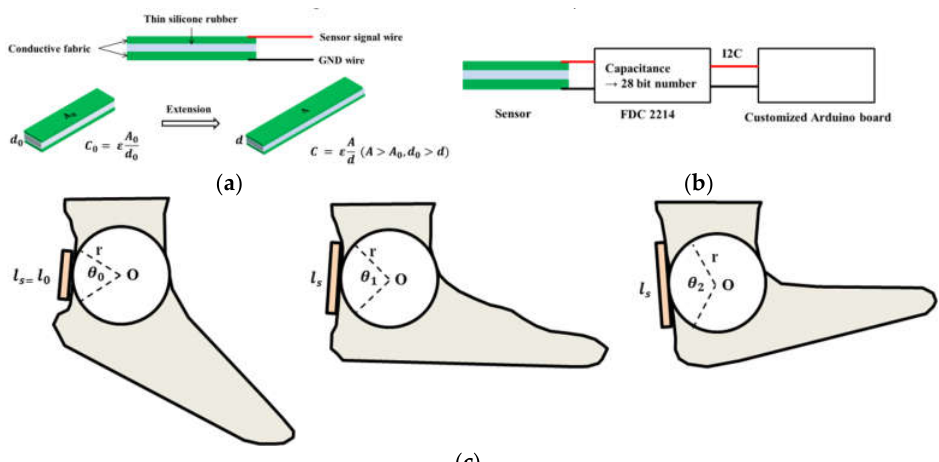
Figure 2. ( a ) Structure and principle of the flexible sensor. The sensor consists of two conductive fabric pieces as electrodes and a thin silicone rubber dielectric layer. A change in the length of the sensor causes a change in the capacitance level, and measuring the capacitance level is the operating principle of the sensor. ( b ) Entire circuit of the flexible sensor system. The FDC 2214 board changes the capacitance value to a 28 bit digital number. The Arduino board displays a digitized number. ( c ) Conversion of ankle angle to strain of the sensor. We assumed that the sensor is extended by the cylindrical behavior of the ankle angle.